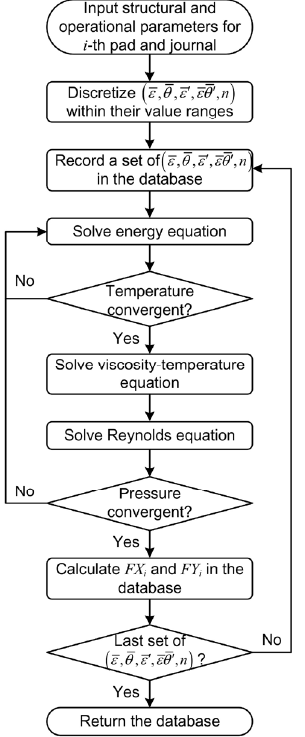
Fig. 3 Flow chart of the NFFF database